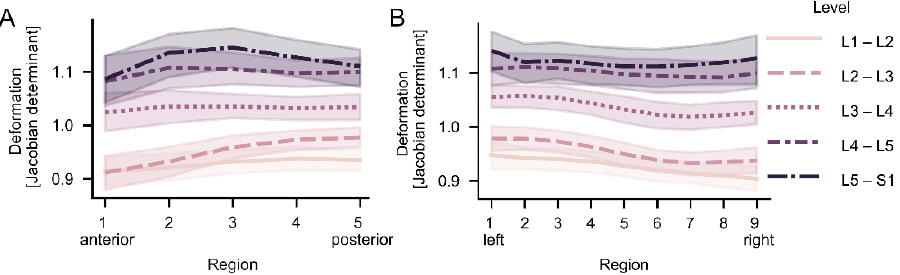
Figure 4. Regional variation of the deformation for different spine levels. Mean intradiscal deformation with (<1 = expansion, >1 = compression) as a function of the spine level for ( A ) the nine mid slices of the disc and ( B ) the five anterior to posterior regions of the discs.